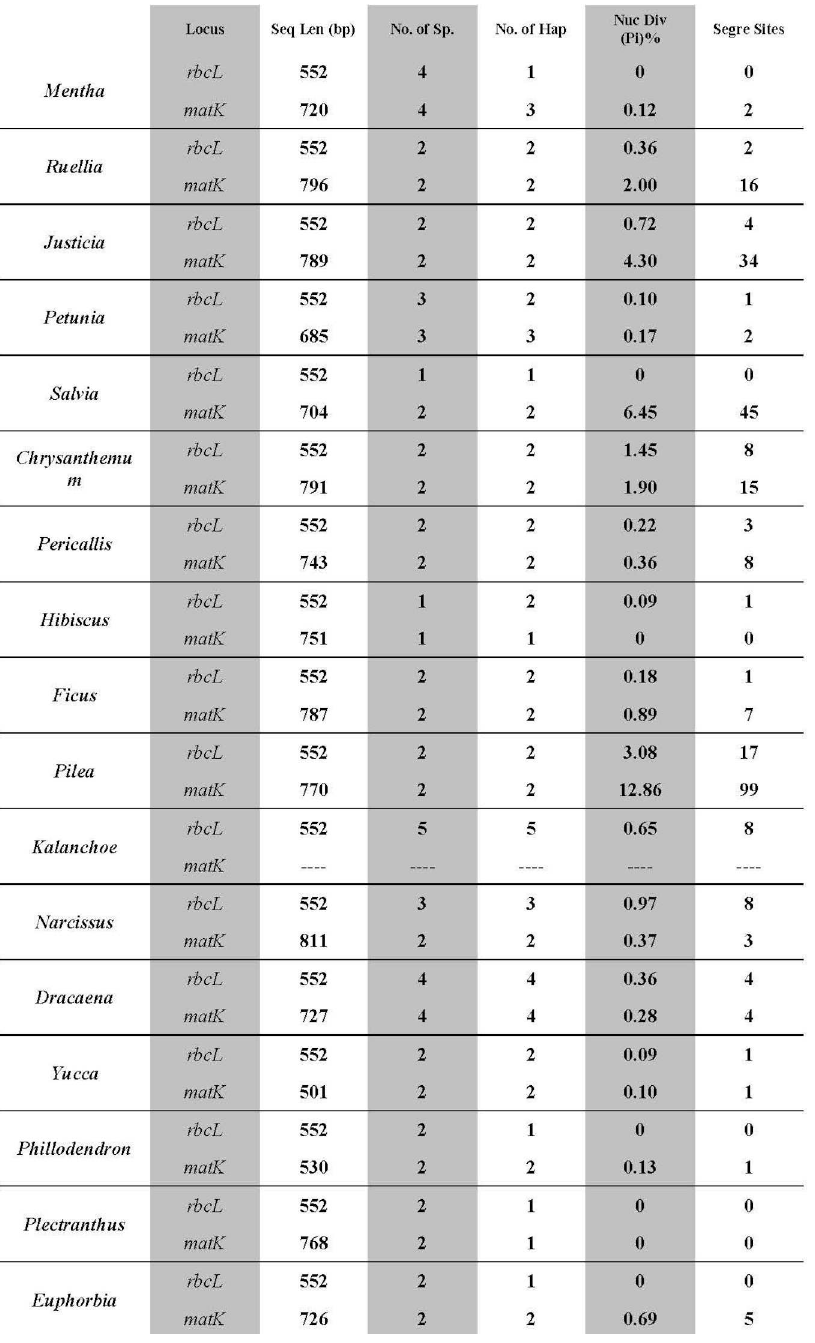
Fig 2. Comparison of two loci tested on severalgenera. No.: Number, Sp.: Species, Seq.: Sequence, Len.: Length, Hap.: Haplotype,Nuc. Div.: Diversity, Segre.: